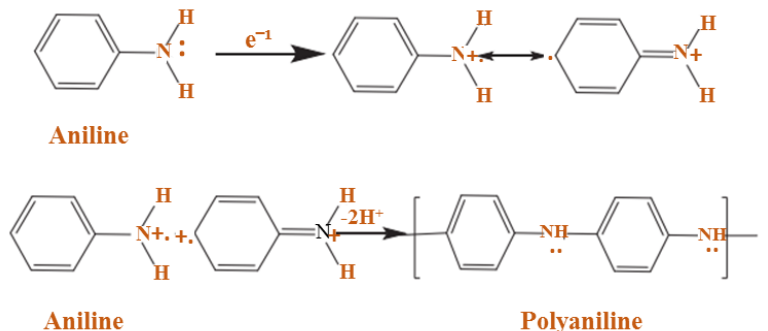
Figure 5. PANI in homo-polymerization. Reproduced with permission from Tan, S.; Zhai, J.; Xue, B.; Wan, M.; Meng, Q.; Li, Y.; Jiang, L.; Zhu, D. Property Influence of Polyanilines on Photovoltaic Behaviors of Dye-Sensitized Solar Cells, Langmuir 2004, 20, 2934 – 2937. American Chemical Society.